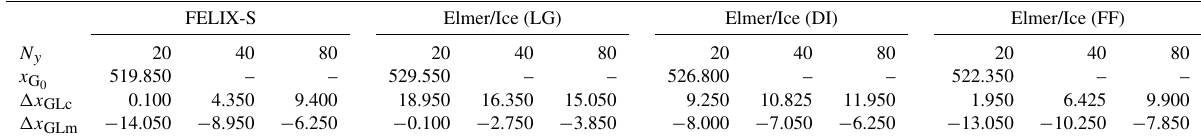
Table 2. Comparison between Elmer/Ice (LG, DI, and FF) and FELIX-S GL positions for the Stnd and P75S experiments. The x G the steady-state GL position for the Stnd experiment. The rows for (cid:49)x GLc and (cid:49)x GLm denote the differences between x G position at year 100 in the P75S experiment at the centerline and margin, respectively. As it is invariant in the across-flow direction, we do not explore the sensitivity of the Stnd experiment to across-flow resolution. All GL positions and differences are given in km. FELIX-S Elmer/Ice (LG) Elmer/Ice (DI)